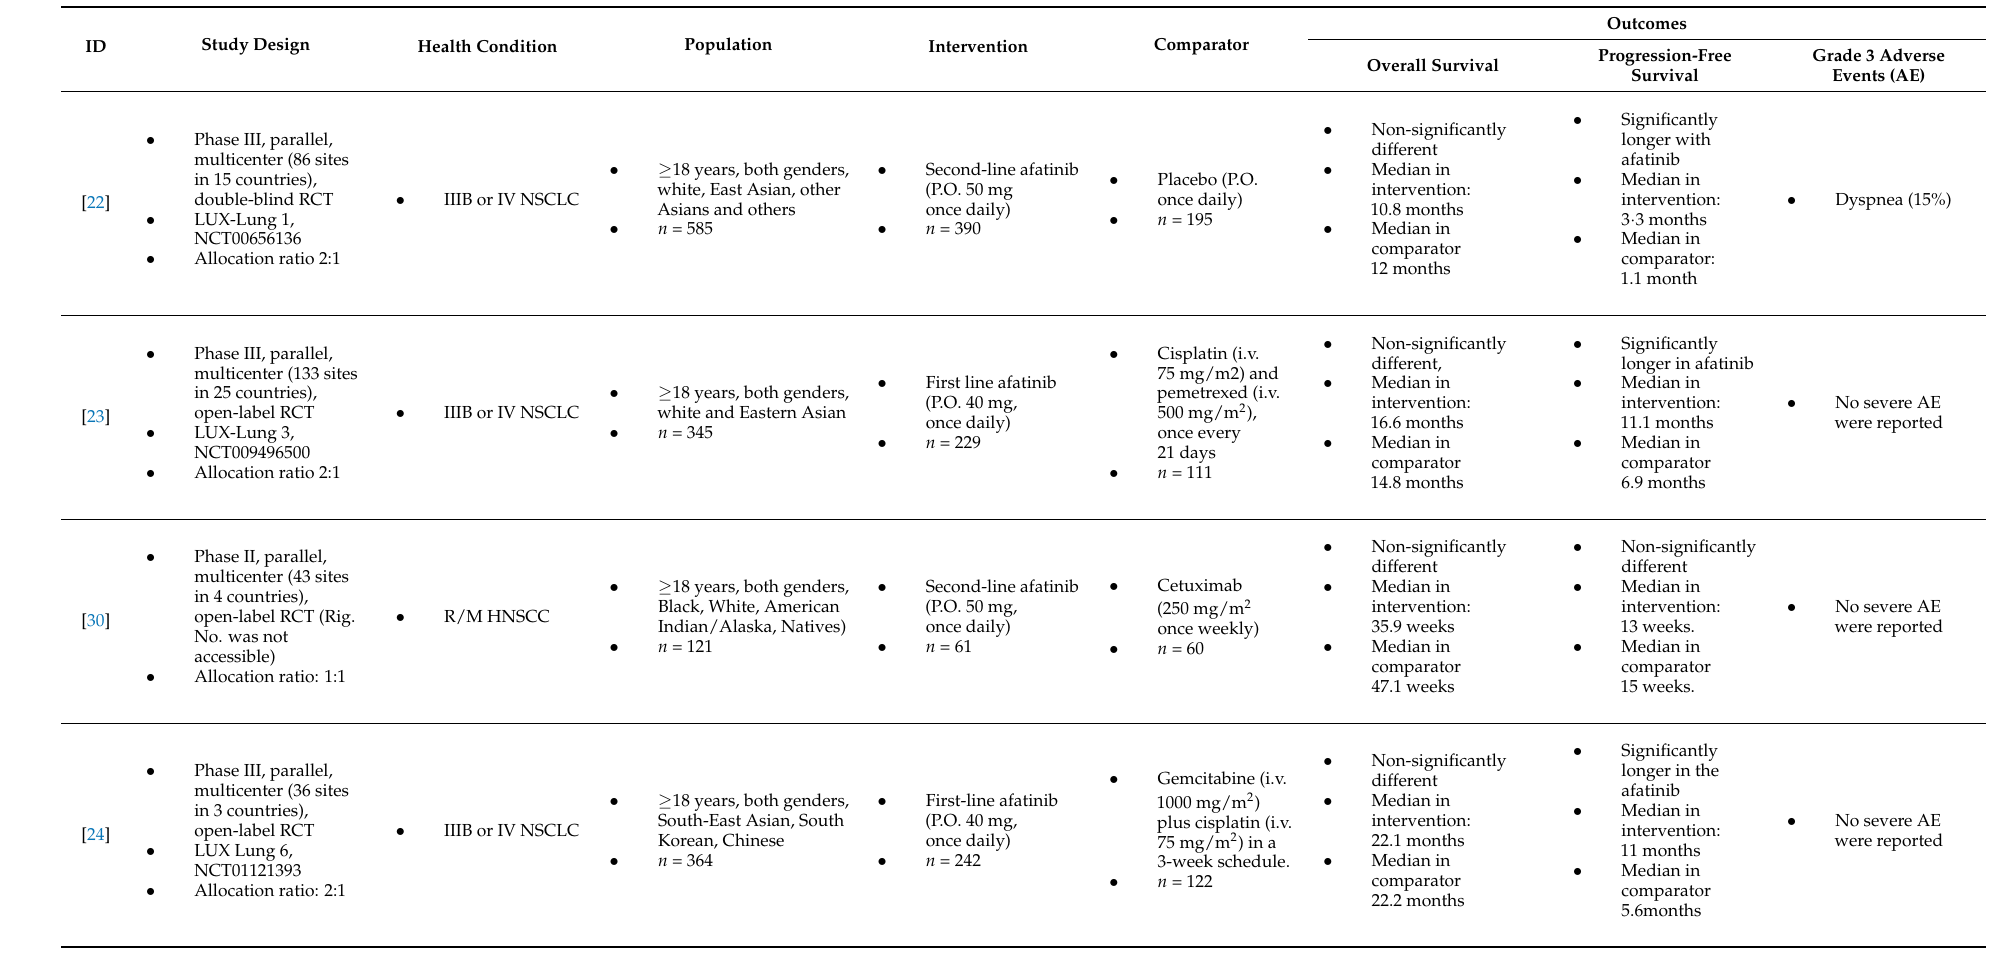
Table A1. Study characteristics extracted from the included randomized controlled